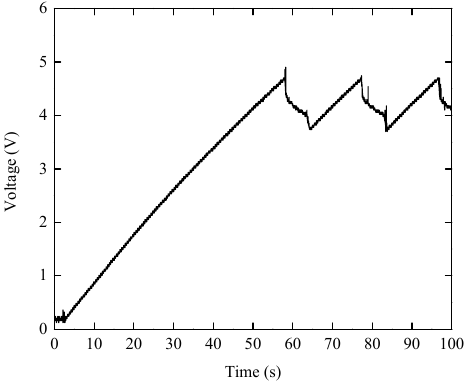
Figure 16. Voltage across the capacitor under base excitation of 0.1 (cid:1859) at 5.4 Hz.